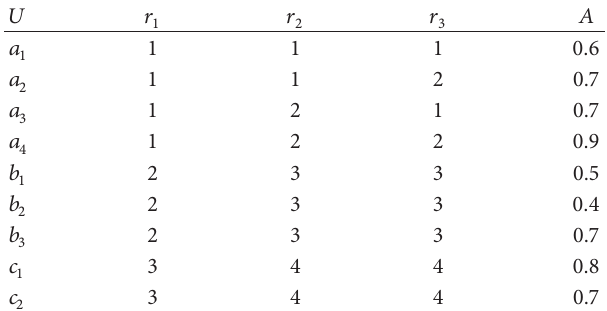
Table 1: Fuzzy-target decision-making